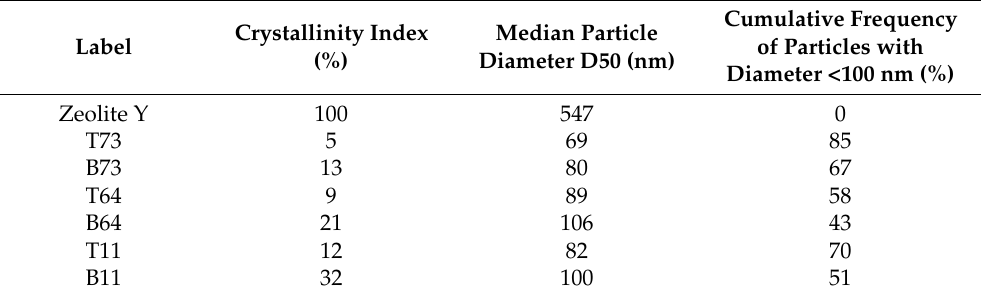
Table 2. Summary of crystallinity index, D50 results, and cumulative frequency of particles with diameter <100 nm for commercial zeolite Y and all ball-milled samples.